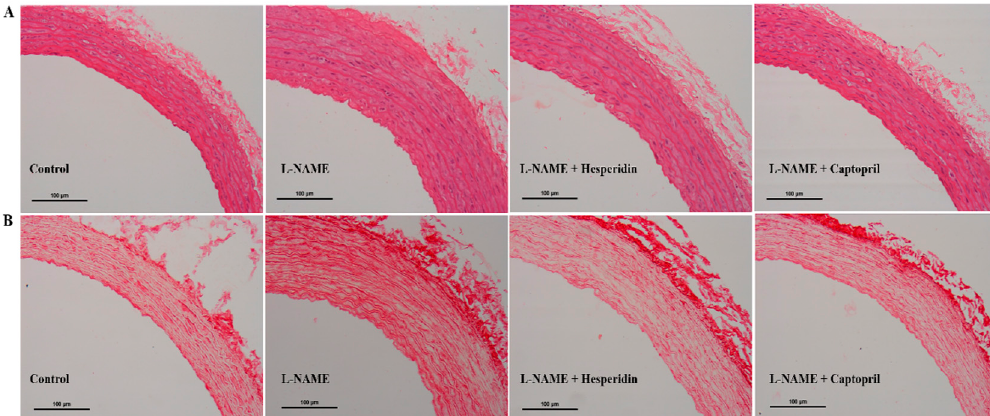
Figure 3. The histology and morphology of thoracic aorta from control, L -NAME, L -NAME + hesperidin (30 mg/kg), and L -NAME + captopril (2.5 mg/kg) groups. Representative images of aortic sections, ( A ) stained with hematoxylin and eosin and ( B ) stained with picrosirius red under a light microscope using a 20× objective lens.